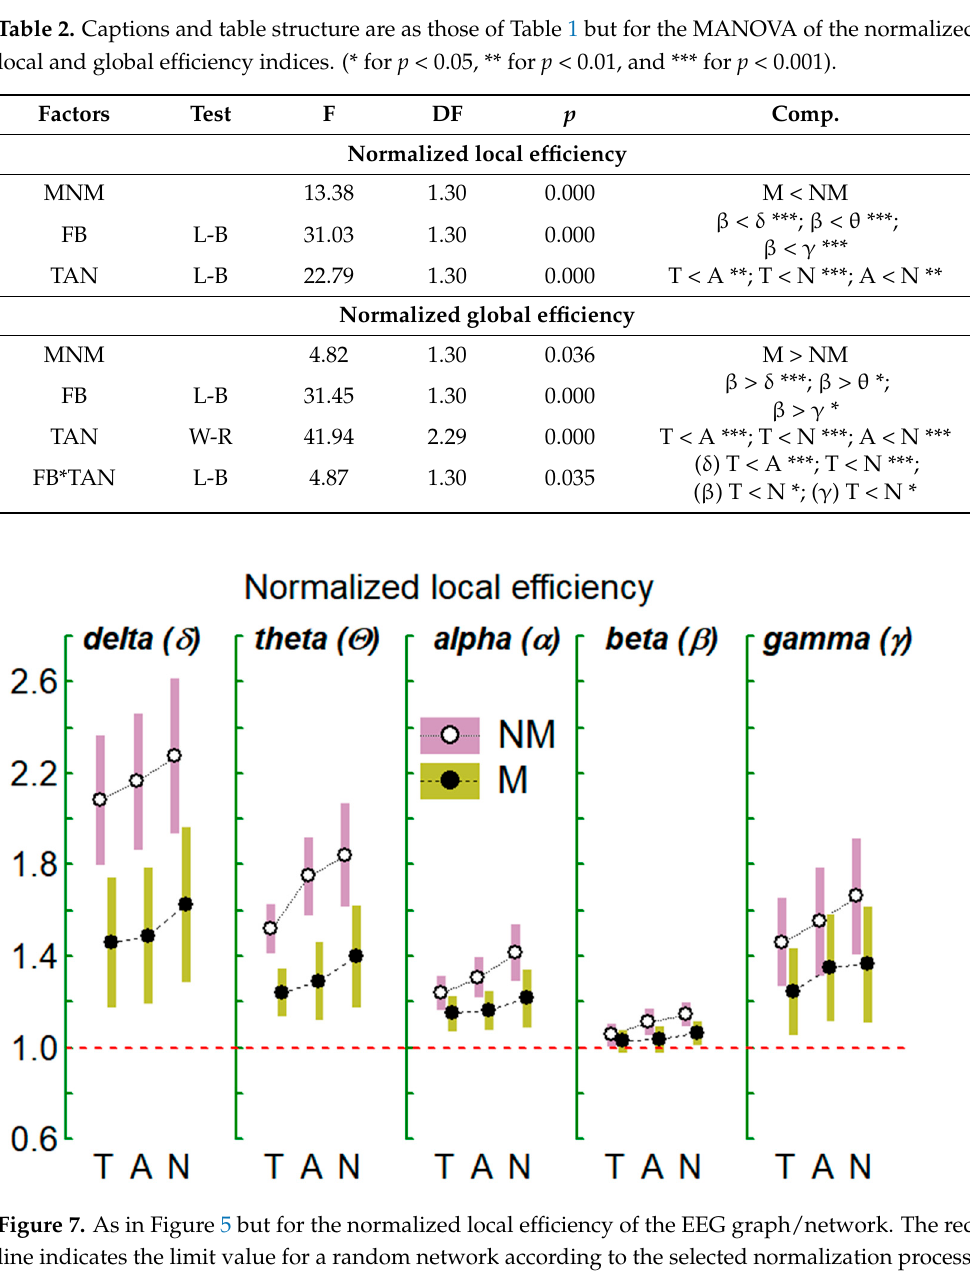
Figure 8. As in Figure 7 but for the normalized local efficiency of the EEG graph/network. 3.3.3. Results of the Graph Metric at the Node Level Topographic Maps The results for graph degree, strength, and normalized local efficiency—calculated for the nodes of each FB-EEG graph in each audition—showed statistically significant differences between tonal-noise and atonal-noise auditions only, for the strength and ef-